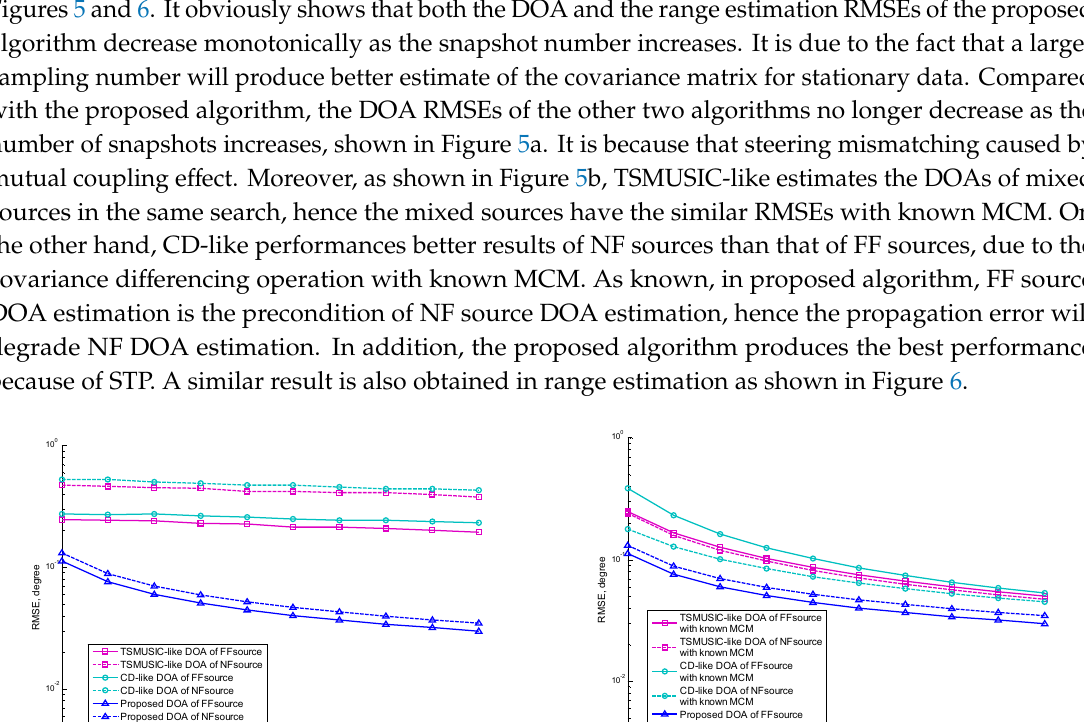
Figure 6. RMSEs of the range estimates versus snapshot number. 5.3. Performance versus SNR In the third simulation, almost all simulation conditions are adopted as the same as those in the second experiment, except that the number of snapshots is set as 400, and the SNR varies from − 5 dB to 20 dB. The RMSEs of the DOA and range estimates, as the changes of SNR, are shown from Figure 7 and Figure 8. Compared with the proposed algorithm, both the DOA and range RMSEs of the other two algorithms no longer decrease as the SNR increases due to mutual coupling effect. It shows that only the proposed algorithm can provide satisfactory DOA estimation performance of mixed sources in Figure 7a. Moreover, in Figure 7b, FF source DOA RMSEs by TSMUSIC-like are similar to NF ones by itself with known MCM. Respectively, CD-like produces better results of NF sources and worse results of FF sources than those by TSMUSIC-like. Additionally, in the proposed algorithm, the propagation error will degrade NF DOA estimation. As a result, the proposed algorithm outperforms the other two algorithms in both DOA and range estimation shown in Figure 8, because of STP.